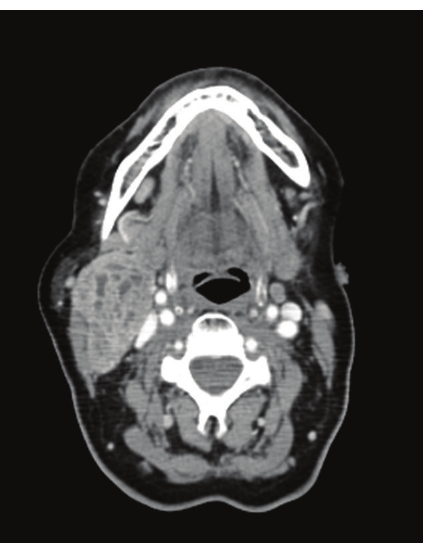
Figure 1: The neoplasm in lateral cervical region (maximum length of 6 cm) confirmed by CT scan.